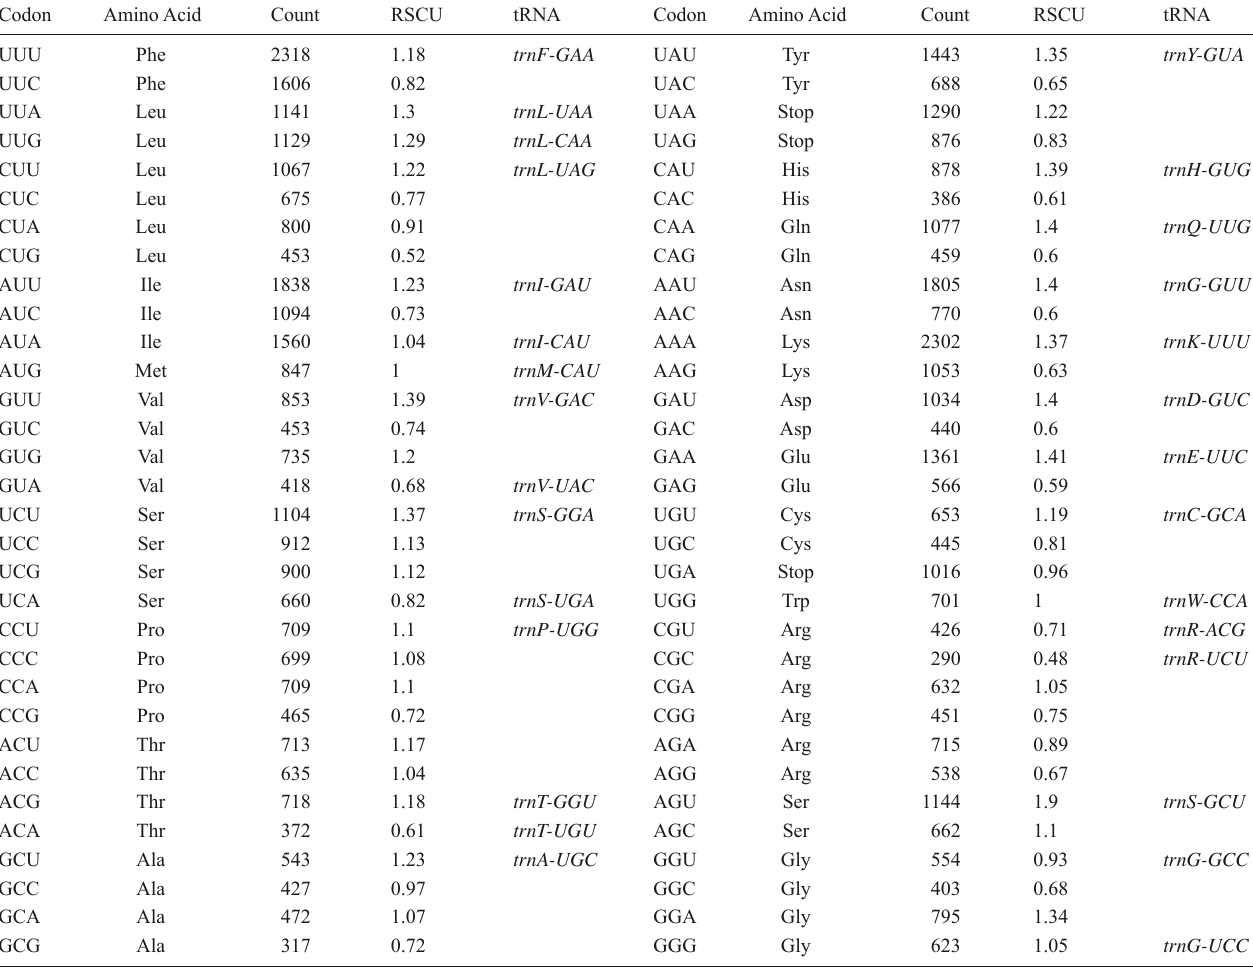
Tab. 5: Codon-anti codon recognition and codon usage in the cp genome of Caralluma quadrangula. Codon Amino Acid